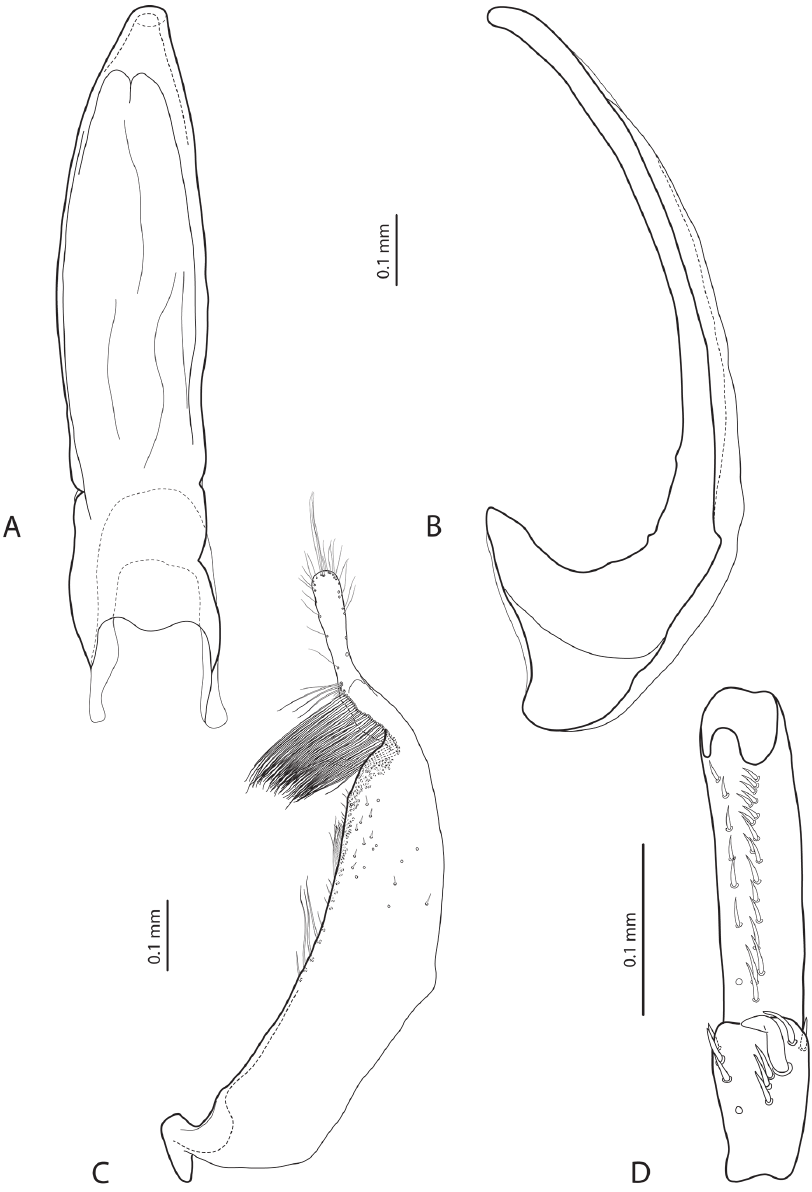
Figure 6. Exocelina okbapensis hajeki ssp. n. A median lobe in ventral view B median lobe in lateral view C paramere in external view D male protarsomeres 4–5 in ventral